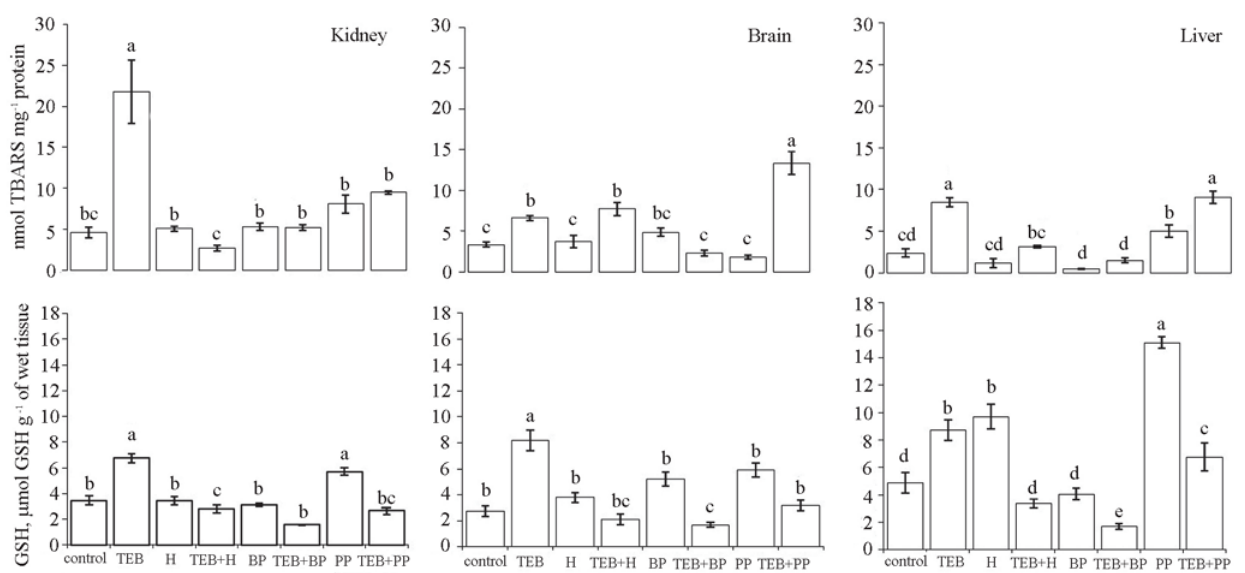
Fig. 1. Levels of TBARS (nmol MDA mg -1 protein) and GSH ((cid:2)mol GSH g -1 of wet tissue) in Rhamdia quelen after exposure to 16.6% of LC of tebuconazole, to bee product, and to tebuconazole + bee product for 96 h. Different small letters indicates 50 statistical differences between the means (ANOVA followed by Tukey´s multiple range test). Mean ± SEM; n = 10. * P < 0.05.